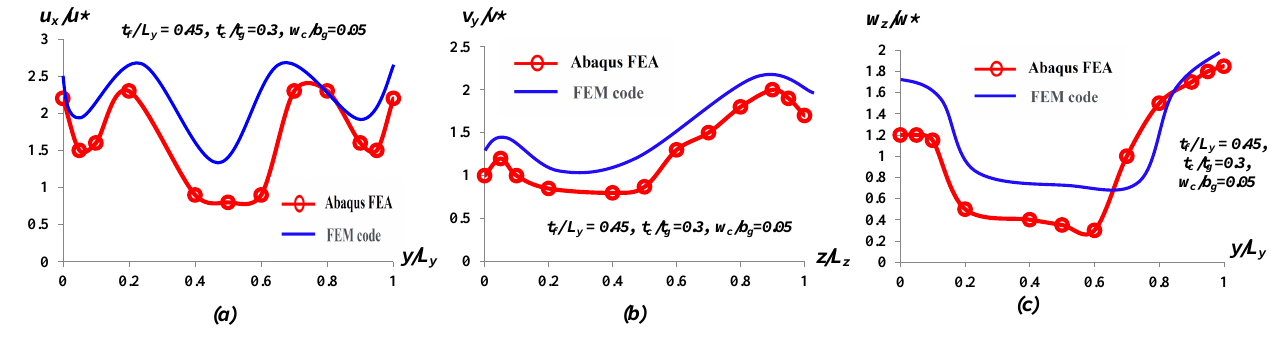
Figure 4. Distribution and comparison of different parts of displacement field between Abaqus FEA and FE model for ( a ) u x / u ∗ along y at z = L z /2 for applied traction t x ; ( b ) v y / v ∗ along x at y = L y /2 for applied traction t y ; ( c ) w z / w ∗ along y at z = L z /2 for applied traction t z at the tip of the blade (i.e., x = L x ) for t f / L y = 0.45, t c / t g = 0.3, and w c / b g =